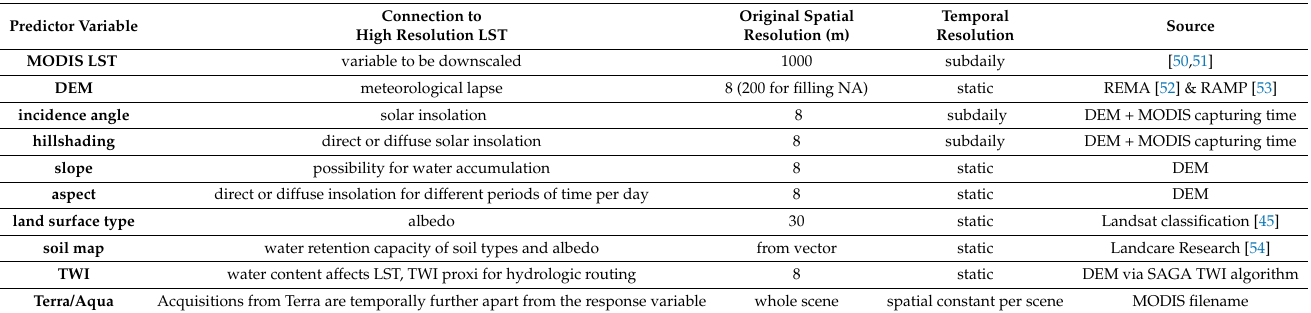
Table 1. Overview of the predictor